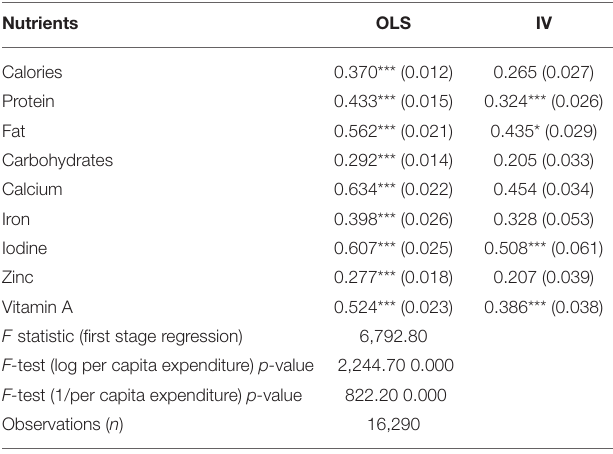
TABLE 10 | Nutrient–income elasticity estimates: non-linear specification with inverse term (Equation